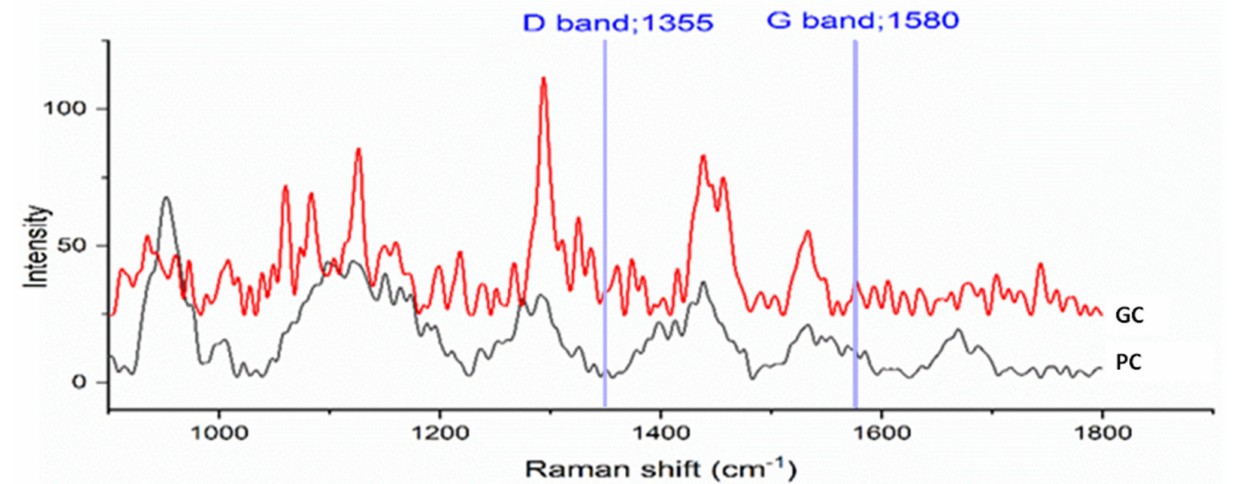
Figure 3. Raman spectra representative of the GC (red line) and PC (black line) compounds.